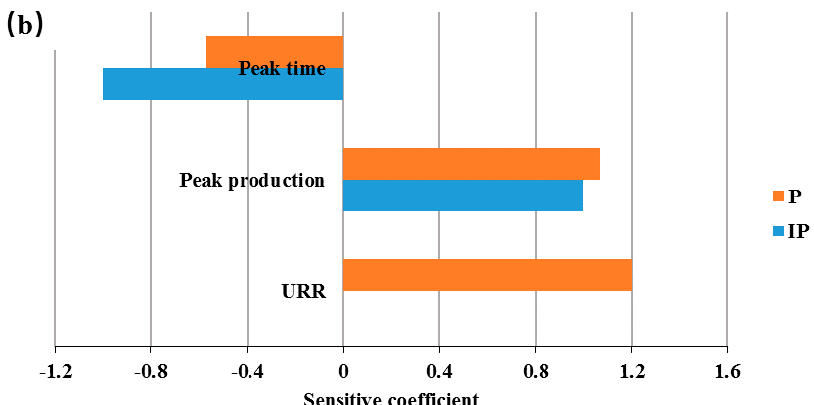
Figure 6. Sensitivity coefficient of IP and price on three key supply factors. ( a ) SA of gas supply by M1; ( b ) SA of gas supply by M2.